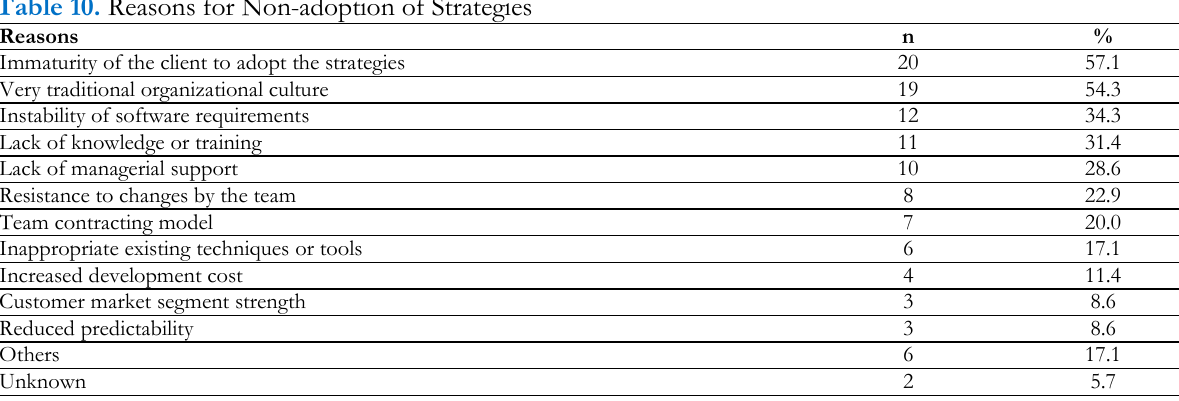
Table 10. Reasons for Non-adoption of